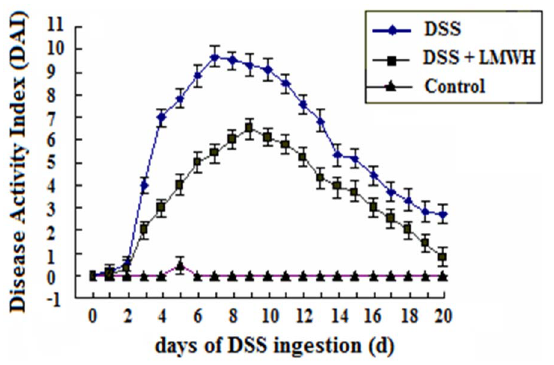
Figure 1. Disease activity index (DAI) of colitis in mice from different experimental groups. The DAI value was calculated as described in Materials and Methods (n=18/group). P , 0.05, DSS plus LMWH or DSS groups vs. the control group from day 3 to day 20 after DSS administration; P , 0.05, the DSS plus LMWH group vs. the DSS group from day 3 to day 20 after DSS